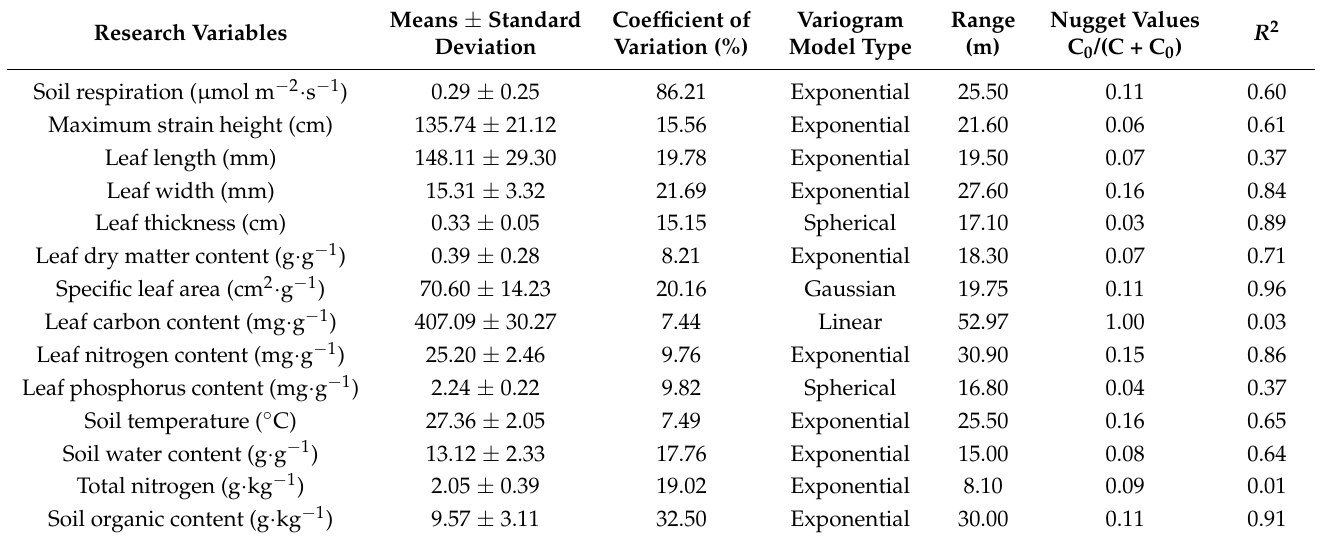
Table 3. Descriptive statistics and the parameters of theoretical models for soil respiration, plant functional traits, and environmental